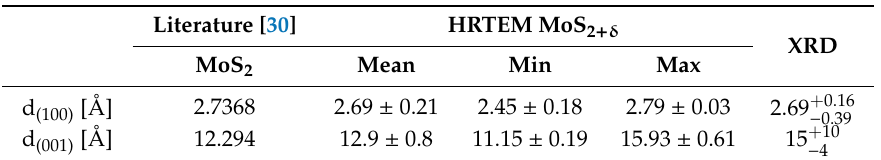
Table 2. Comparison of the (100) and (001) lattice distances of MoS 2 + δ found by transmission electron microscopy (TEM) and XRD with literature values for MoS 2 [30]. The XRD uncertainty is determined by the full width at half maximum (FWHM).